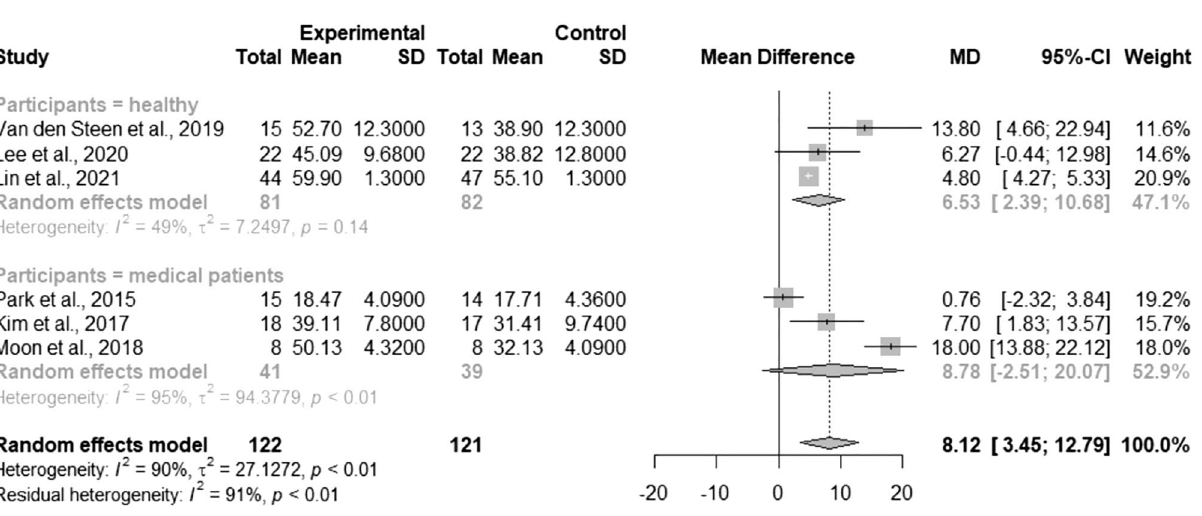
Figure 6. Forest plot of pooled posterior tongue strength after the intervention, comparing the tongue strengthening exercise group and the control group (subgroup analysis by the participants’ characteristics). MD mean difference, CI confidence